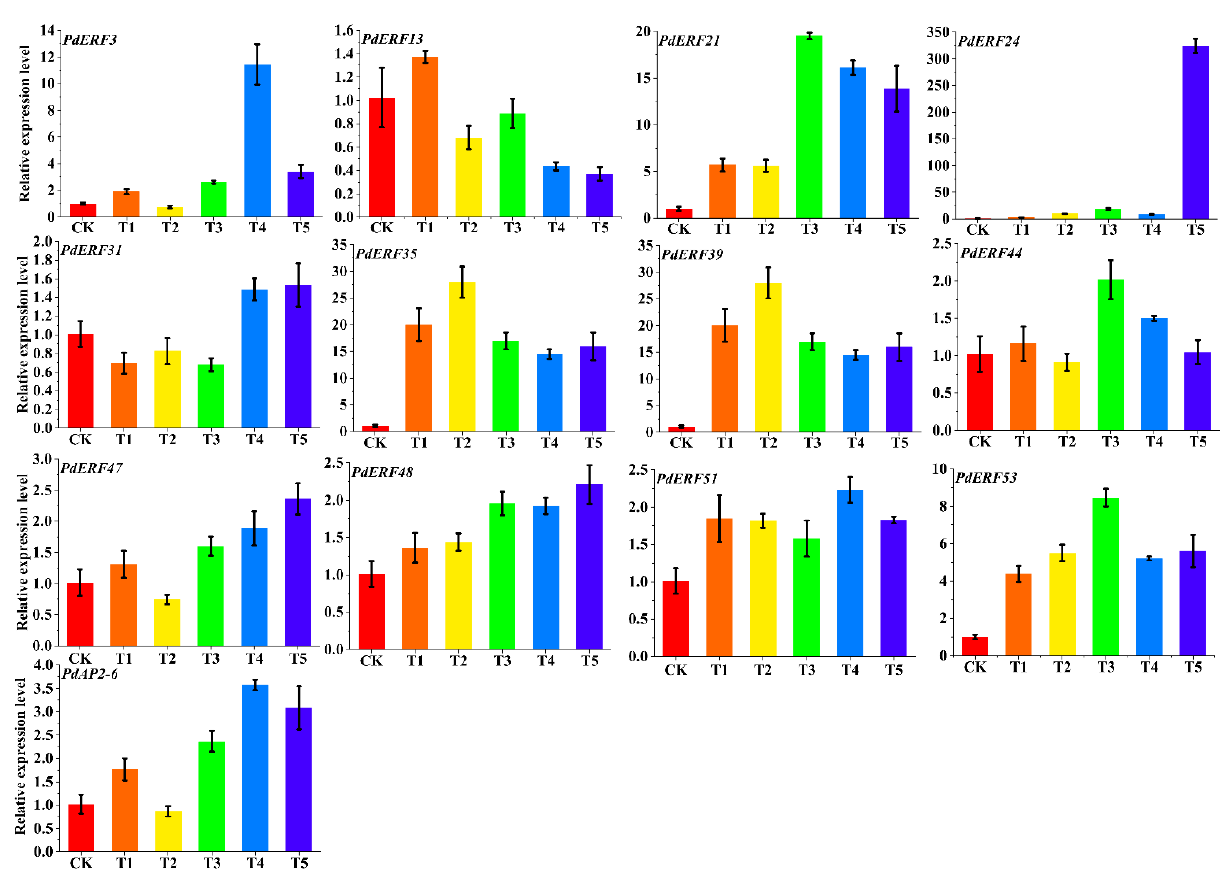
Figure 9. Fluorescence quantitative relative expression of 13 representative PdAP2/ERF genes under six temperature gradient freezing stress treatments in the annual dormant branches of ‘Wanfeng’ almond. CK, T1, T2, T3, T4, and T5 represent − 5, − 10, − 15, − 20, − 25, and − 30 ◦ C, respectively. The ordinate represents the relative expression level of genes, and the abscissa represents CK, T1, T2, T3, T4, and T5 from left to right.